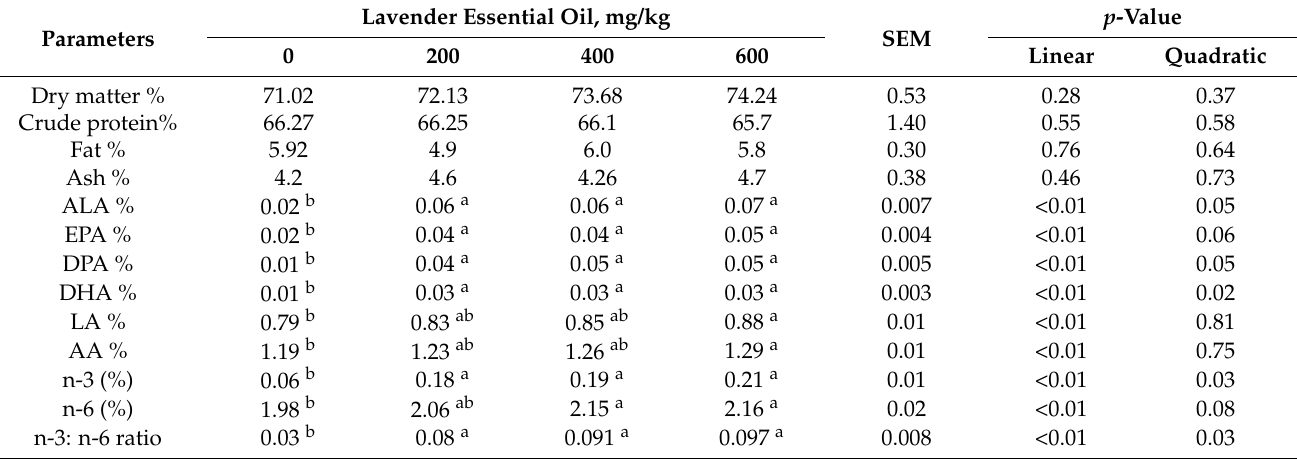
Table 5. Impact of lavender essential oil on the breast muscle’s chemical and fatty acid composition.